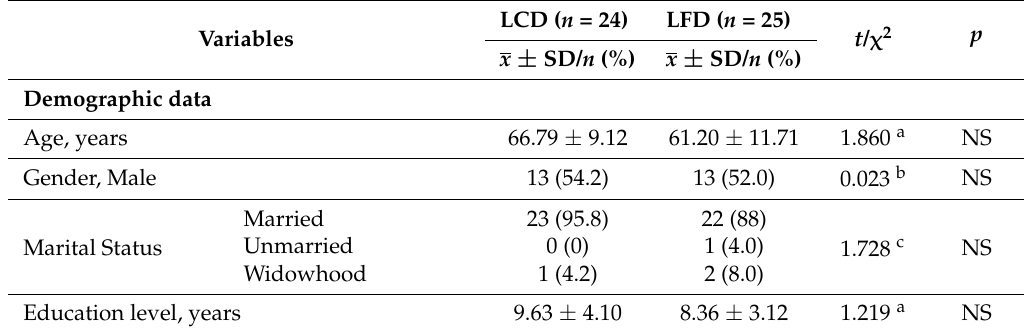
Figure 2. Flow diagram of the patients. Table 1. Baseline characteristics.